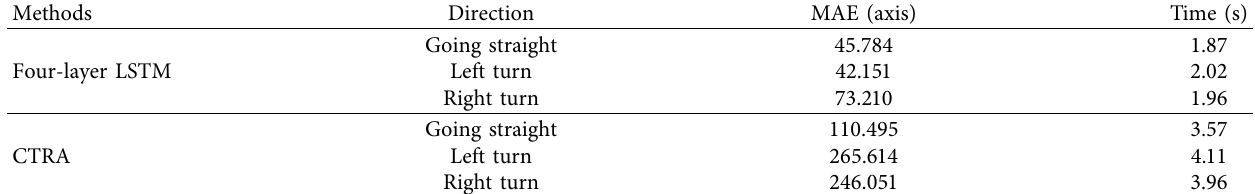
Table 4: Comparison of prediction algorithms.